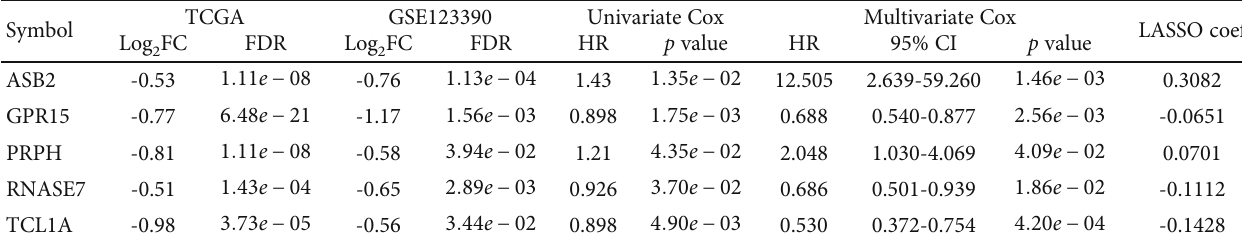
Table 2: The optimal signature for prognosis